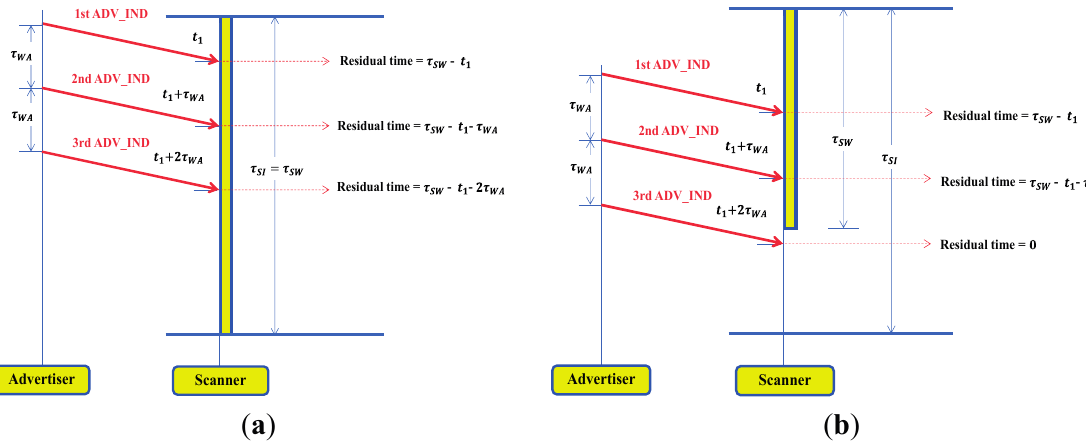
Figure 3. Continuous scanning (τ continuous scanning without sleeping (τ